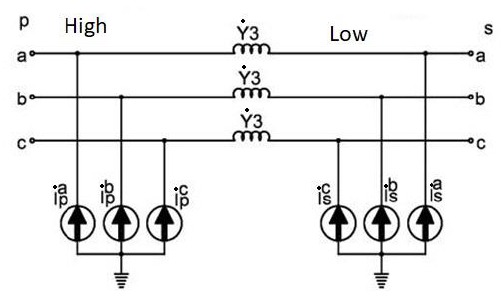
Figure 1. Representation of a distribution transformer with a wye-grounded / wye-grounded connection [28].